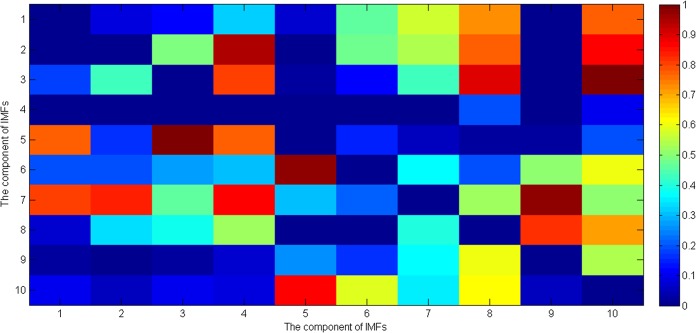

p values of Student’s t test of the entropy ratios of the instantaneous frequency of ith and jth component of IMFs of the uterine EMG signals.